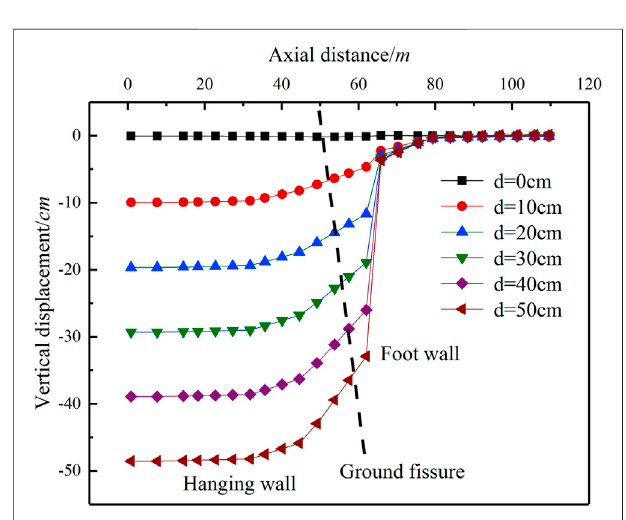
FIGURE 6 | Structural deformation curve of underground utility tunnel obliquely crossing the ground fi ssure (inclination 60 ° ).